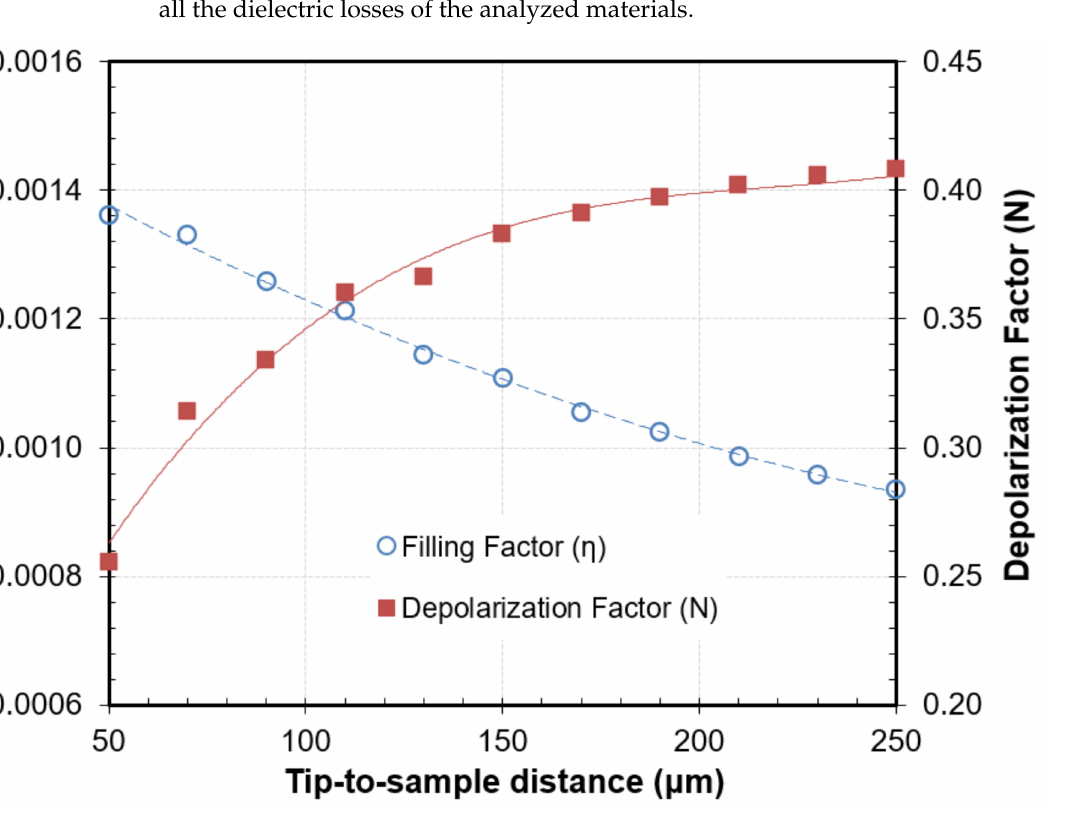
Figure 4. Calibration parameters, η and N, of the cavity perturbation method determined with reference samples as a function of the tip-to-sample